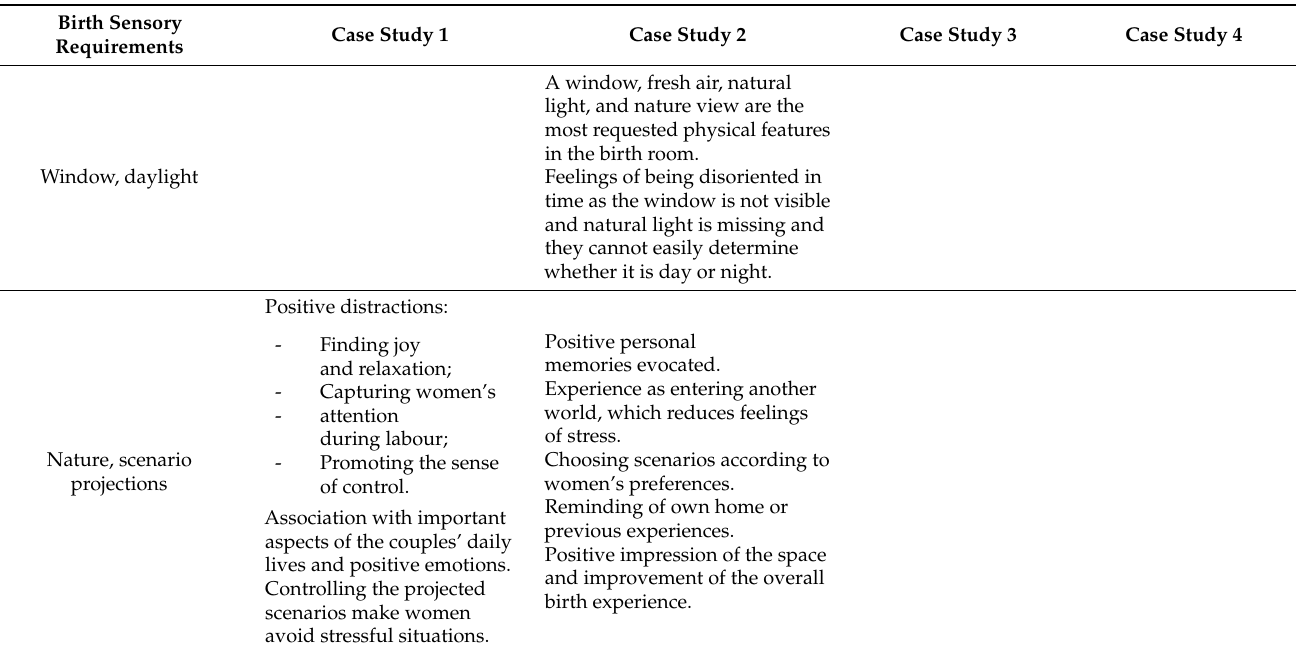
Table 5. Birth sensory requirements: data of impact